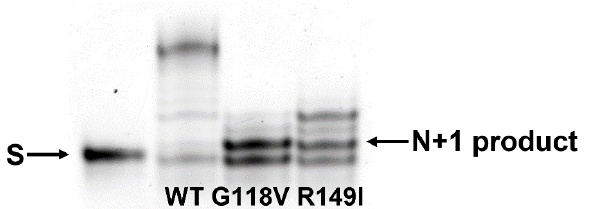
Figure 8. DNA elongation by Pol β variants via strand-displacement synthesis. [DNA substrate] = 0.5 µ M, [enzyme] = 1.0 µ M, and [dNTP] = 10 µ M. Reaction time was 1 min. “S” denotes the initial 19 nt FAM-labeled primer strand. “N + 1 product” represents the DNA product after gap-filling incorporation of a nucleotide resulting in the formation of a nick-containing 20 nt structure. Upper products are results of strand-displacement DNA synthesis.